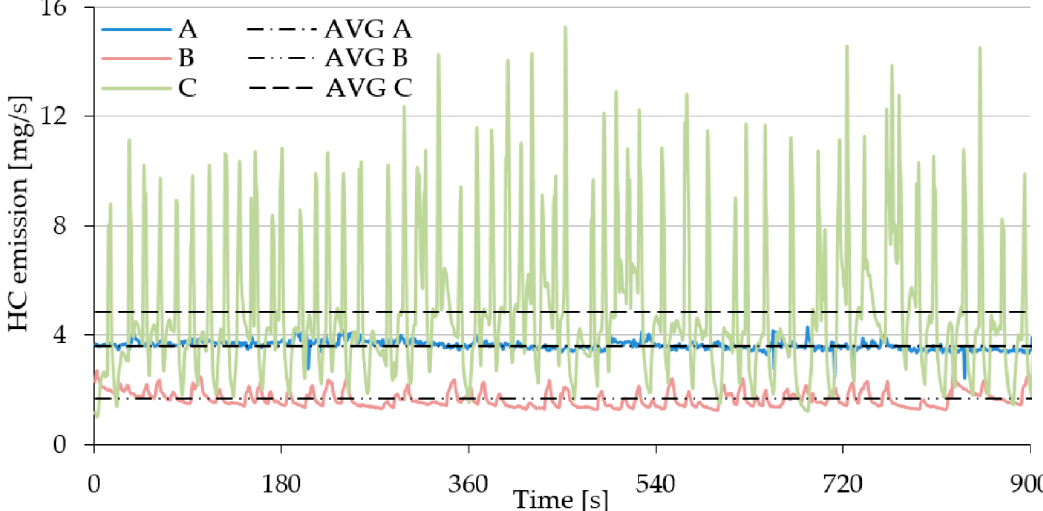
Figure 3. HC emission as a time function during the chipping process: A: Carburettor fuel supply system; B: Injector fuel supply system; C: Injector fuel supply system equipped with an adaptive drive control system.